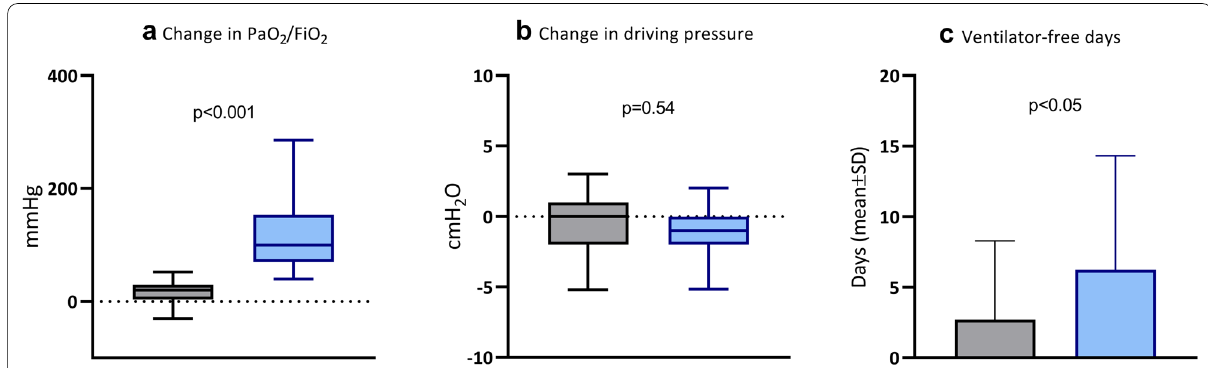
SD). Significant P values are highlighted in bold ±